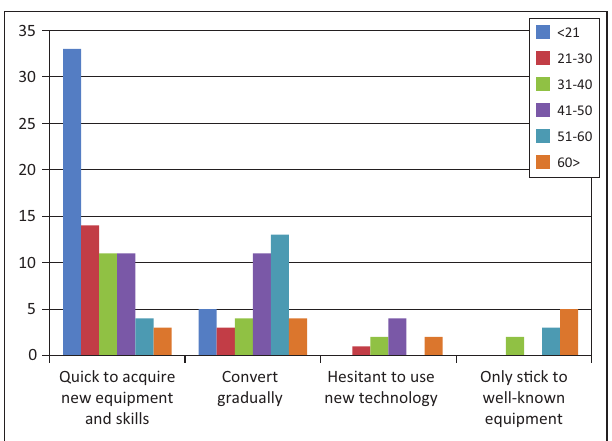
FIGURE 7: Age of respondents and ability to adapt to new